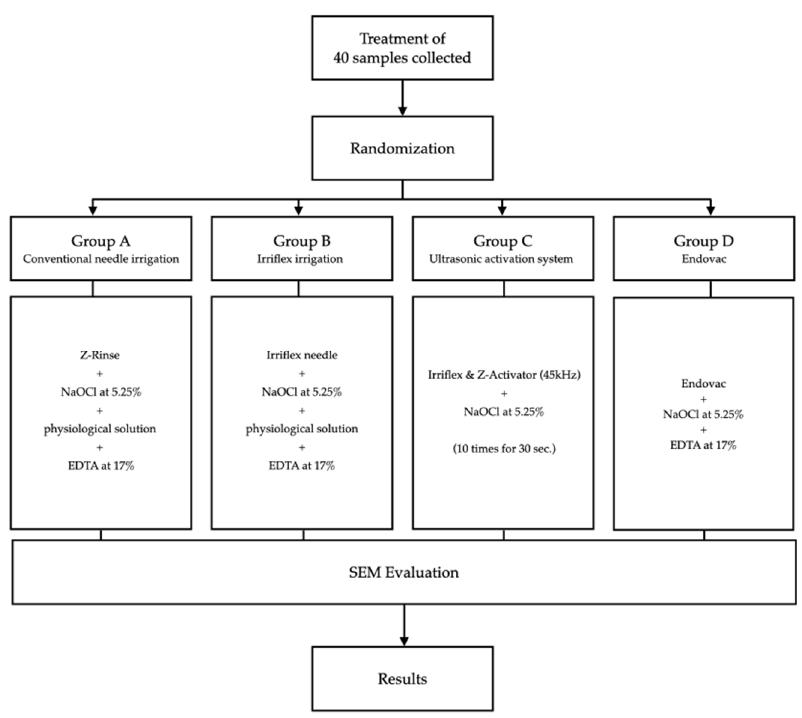
Figure 1. A schematic diagram of the experimental setup.